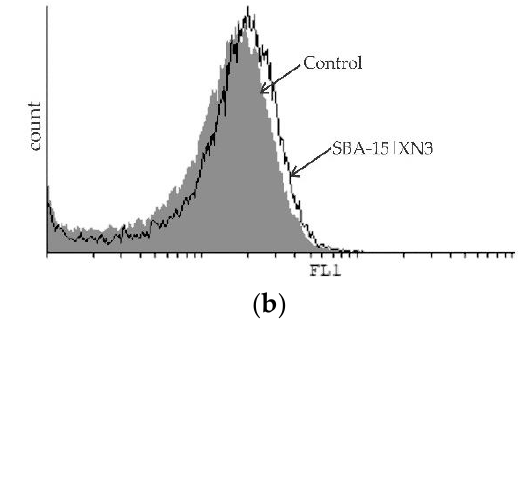
Figure 4. Dose-dependent viability decrease of B16F10 melanoma cells treated with various concen- trations of SBA-15|XN1 – SBA-15|XN3 ( a – c ) for 48 h. * p < 0.05 compared to the untreated control cells. c [ µ M] is calculated according to amount of XN by TGA.